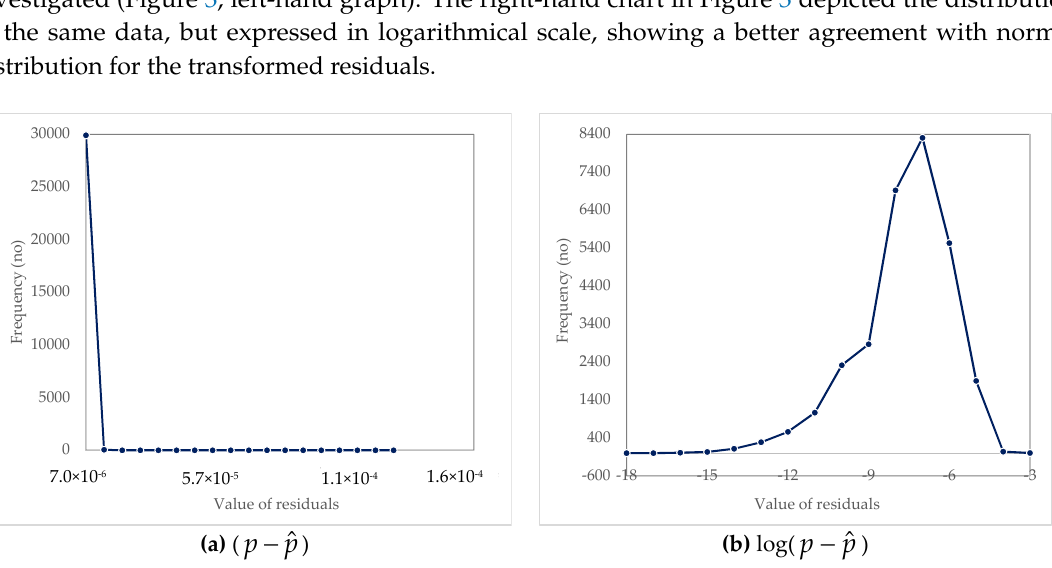
Table 8. Residuals: descriptive statistics.